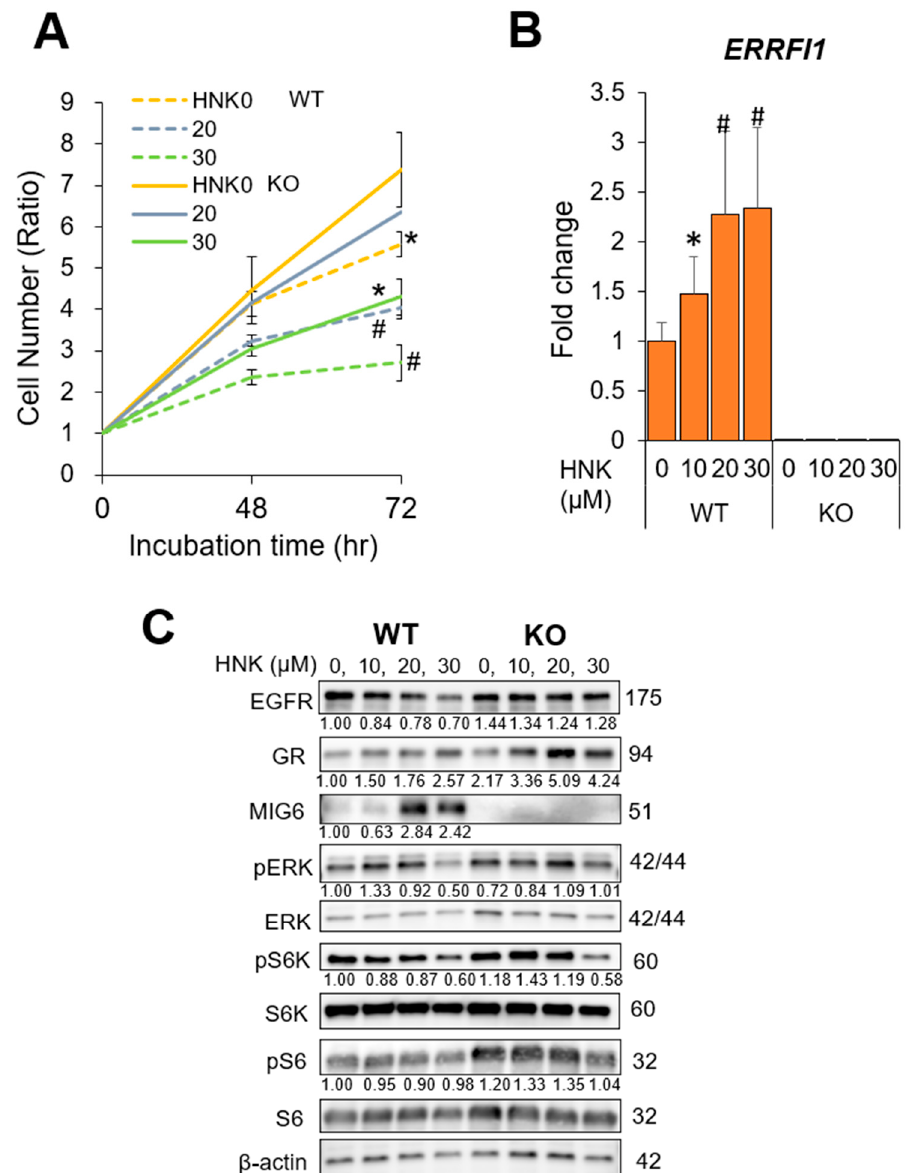
Figure 4. Mitogen-inducible gene 6 (MIG6) knockout (KO) abrogates the inhibitory effects of honokiol (HNK) on hepatocel- lular carcinoma (HCC) cell proliferation.( A ) Viability and proliferation of parental and CRISPR MIG6 KO Hep3B cells 48 and 72 h after incubation with 0, 20, or 30 µ M HNK. ( B ) Relative mRNA expression of ERBB receptor feedback inhibitor 1 ( ERRFI1 ) in HCC cells treated with 0, 10, 20, or 30 µ M HNK (WT, wild-type Hep3B cells; KO, CRISPR MIG6-knockout clone cells). ( C ) Immunoblot analysis of parental and CRISPR MIG6 KO Hep3B cells 24 h after incubation with the indicated concentrations of HNK. Protein expression and phosphorylation of EGFR signaling-related molecules are presented with β -actin as a loading control. All graphs represent the mean ± SD (* p < 0.05, # p < 0.01 vs. the same cells without HNK treatment (HNK0, A) or vs. WT cells (HNK0, B)).